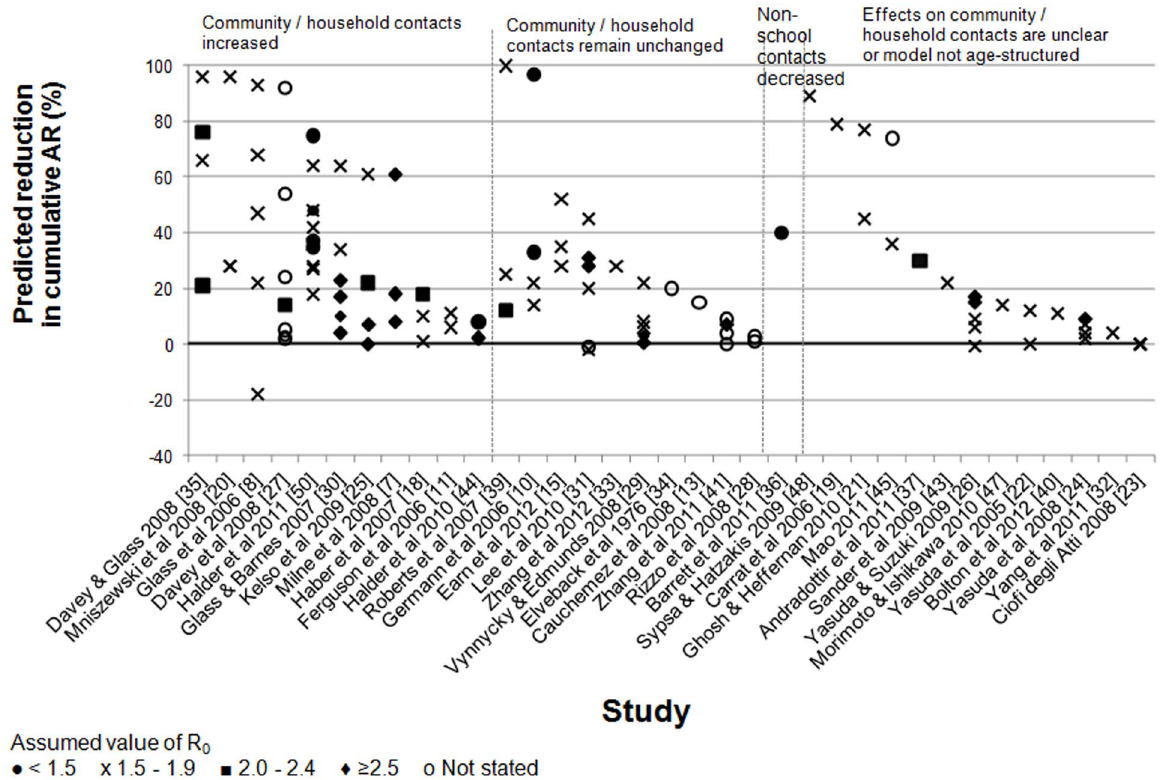
Figure 2. Summary of the estimated effects of school closures on cumulative incidence of pandemic influenza (all ages) predicted by the modelling studies. Different symbols are used to reflect the assumed value for R 0 . The findings are grouped according to whether they assumed that the community/household contacts increased, remained unchanged, the assumptions about contact were based on empirical data or were unclear. Some studies assumed that workplaces and/or other public places also closed [11,23,28]. All studies that stated their assumptions regarding the effects of school closure on contact patterns assumed that contacts between school-aged children were reduced or eliminated.